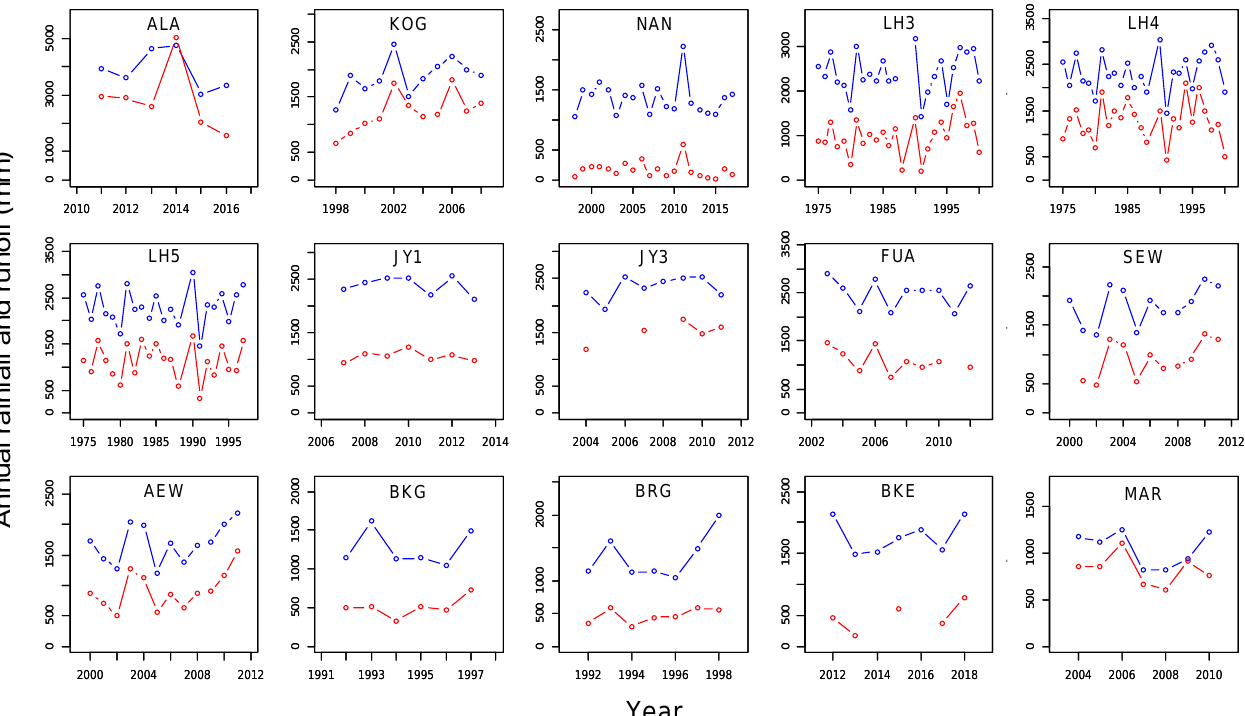
Figure 1. Time series of annual rainfall (blue) and runoff (red) for each catchment. Figure 2 compares the mean annual rainfall and runoff across all catchments. The mean annual rainfall ranged from 1051 mm at the northernmost MAR to 3873 mm at the southernmost ALA. The mean annual runoff ranged from 169 mm at NAN to 2841 mm at ALA. Although there were differences in climate, forest type, and geological characteris- tics between catchments (Tables 1 and 2), there was a significant positive correlation be- tween the annual rainfall and annual runoff, indicating a strong influence of annual rain- fall on annual runoff, as found in most similar studies [10,30 – 32].